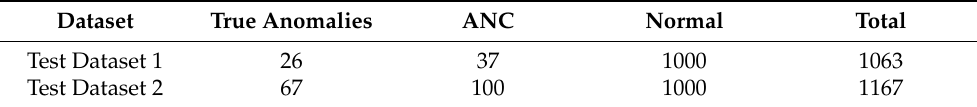
Table 1. Composition of training and testing datasets to evaluate the performance of the models. Dataset True Anomalies ANC